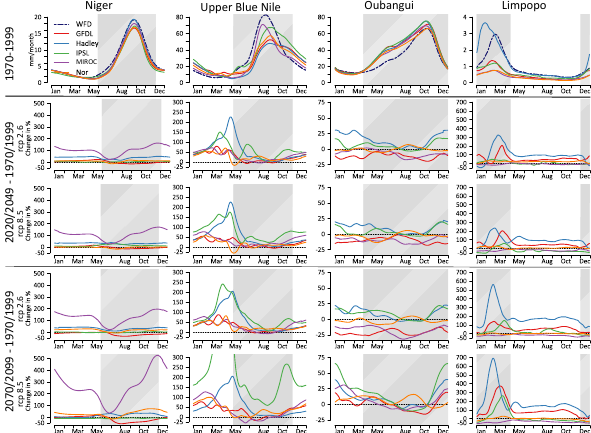
Fig. 8. First row: seasonality of monthly discharge for the reference period; second and third rows: changes in % of discharge between a near scenario period and reference periods for RCP 2.6 and RCP 8.5; fourth and fifth rows: changes in % of discharge between a far scenario period and reference periods for RCP 2.6 and RCP 8.5. Recent rainy season as grey shaded